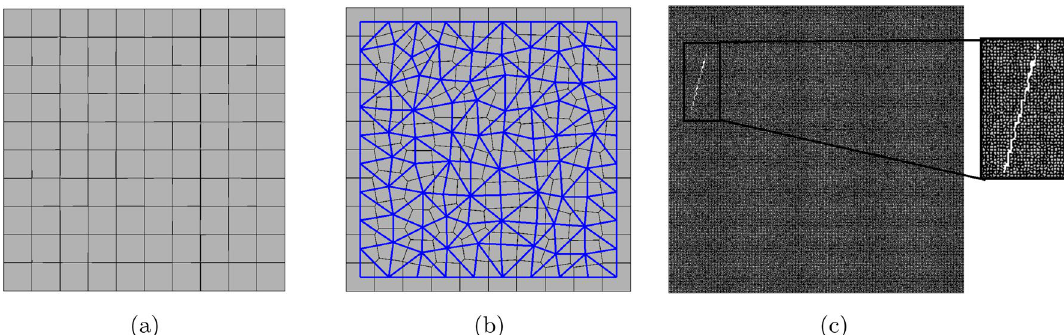
0.01 , ( b ) generated lattice = 0.5 , and ( c ) generated random crack, when =